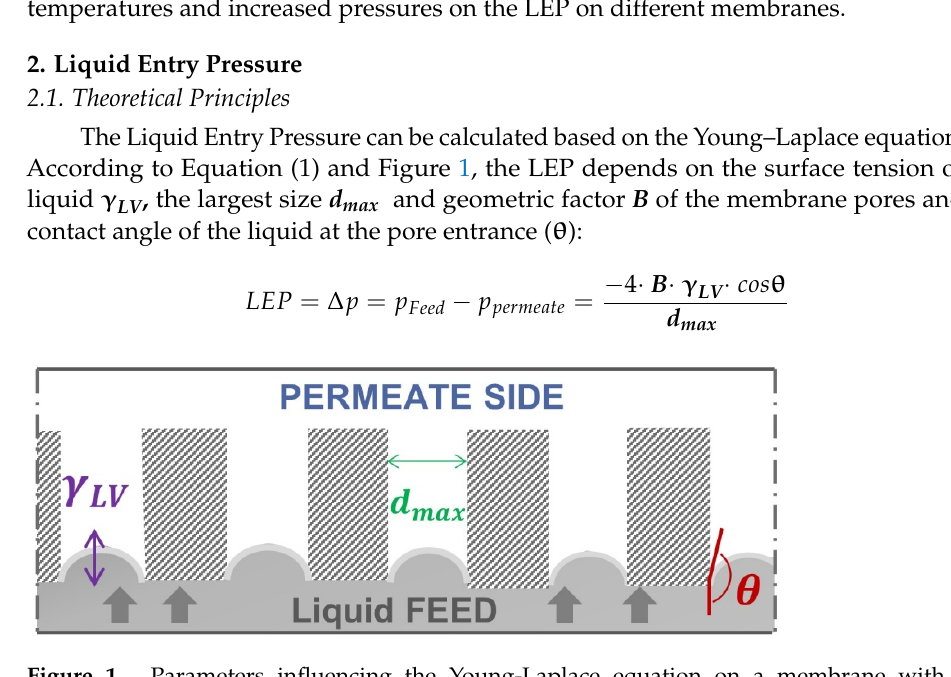
Figure 1. Parameters influencing the Young-Laplace equation on a membrane with ideal cylindrical